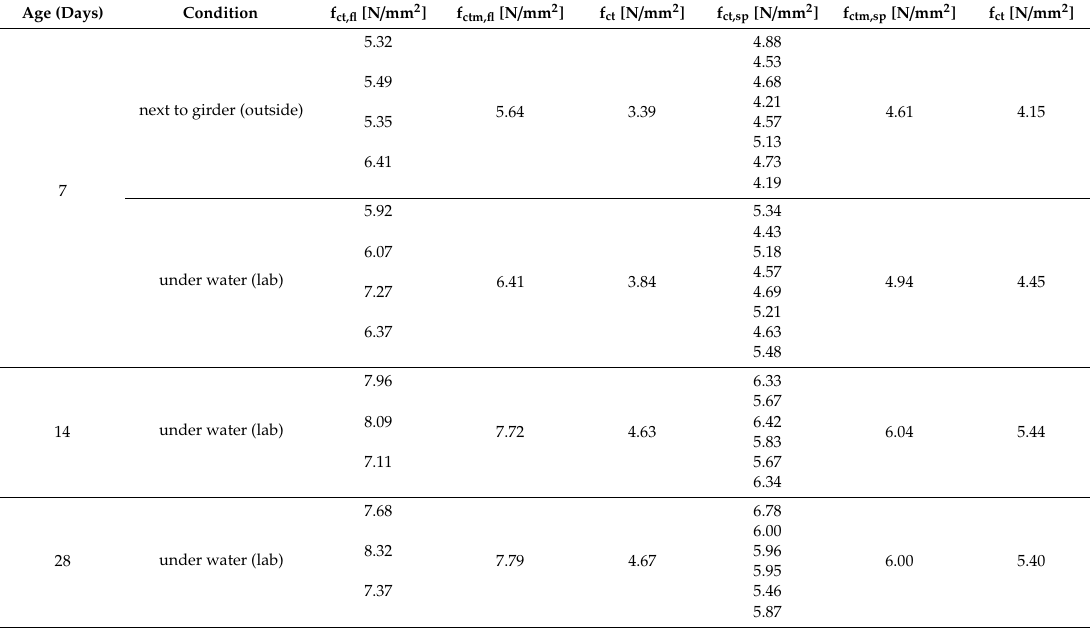
Table 3. Results of the flexural and splitting tensile